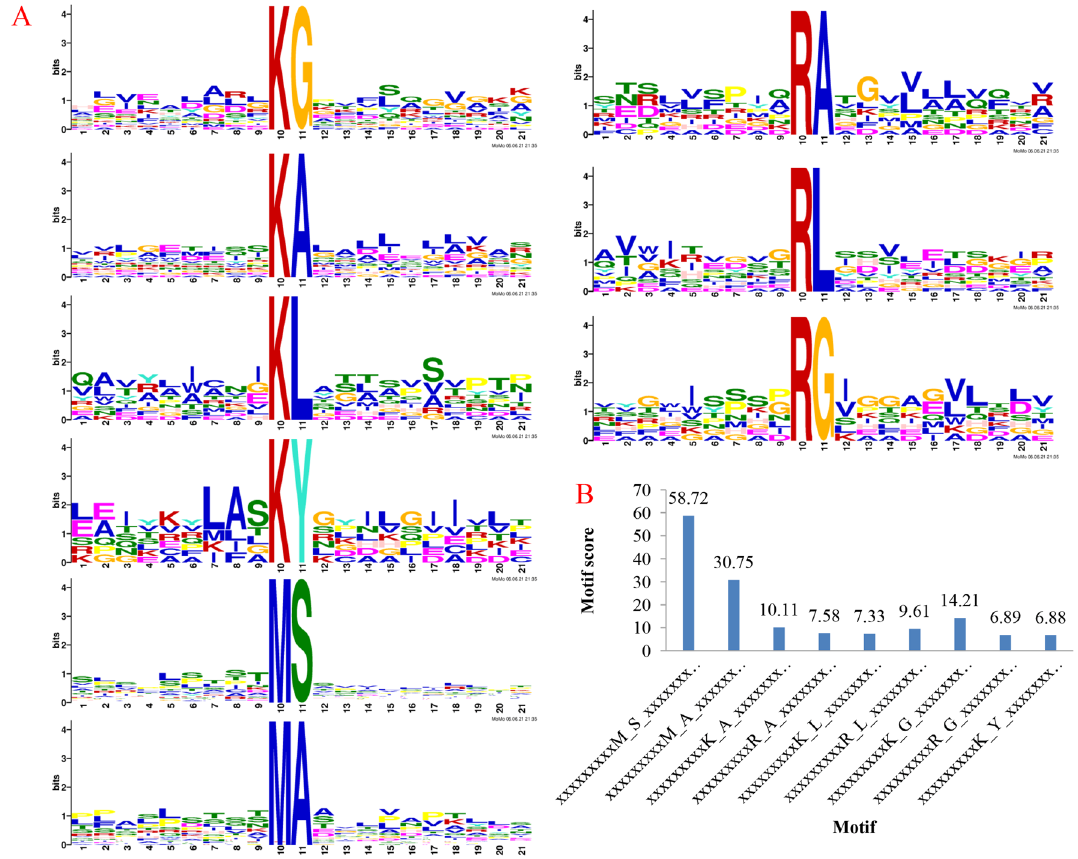
Figure 3. Properties of acetylation peptides in P. umbellatus . ( A ) Acetylated motifs and conservation of acetylated sites. ( B ) The motif